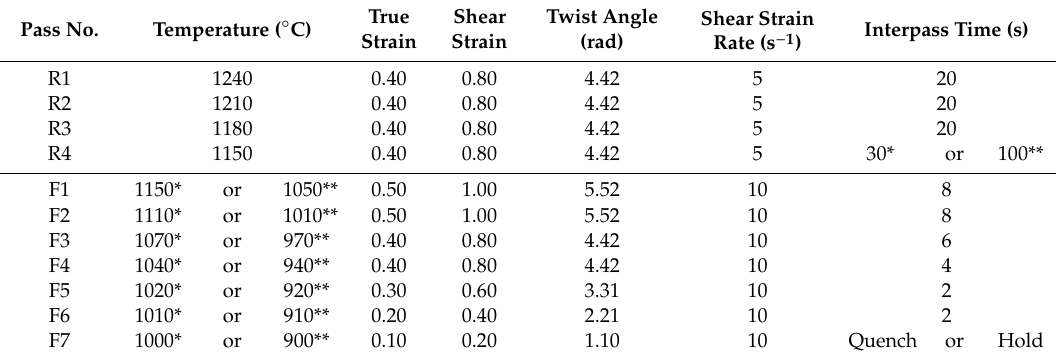
Table 3. Hot Torsion Testing Schedule to Simulate High T Finish* and Low T Finish** Processing. Pass